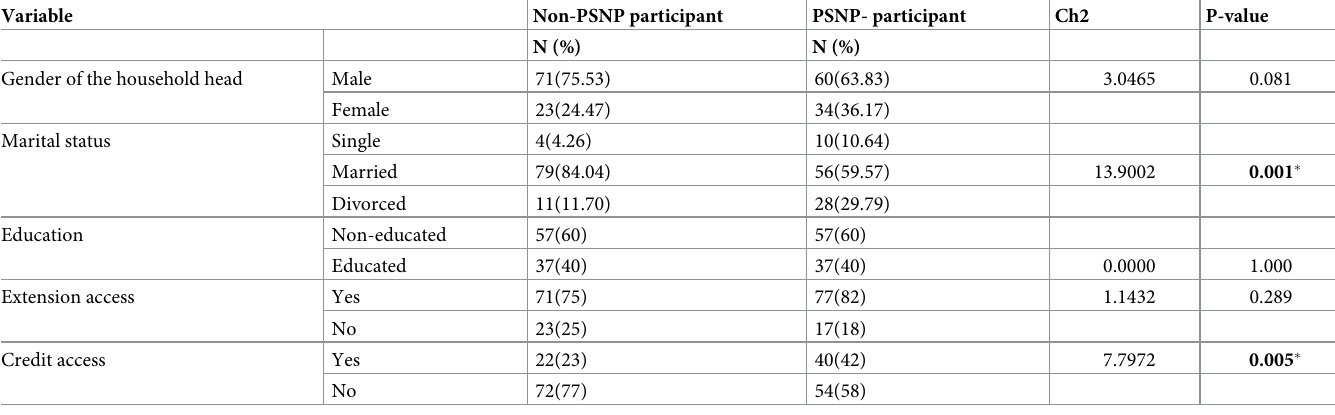
Table 3. Categorical variables chi-square